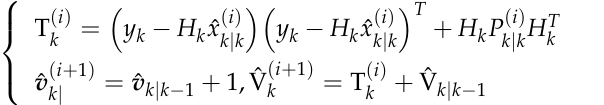
The approximate probability density function of the imprecise measurement noise covariance matrix R k is then updated by Equation (45).